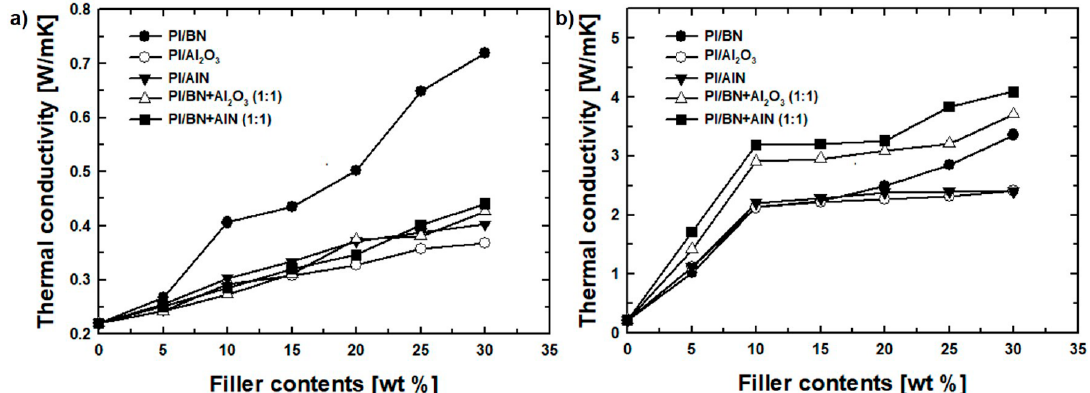
Figure 2. Thermal conductivity along the ( a ) through-plane and ( b ) in-plane directions of the composite films plotted as functions of the filler content.